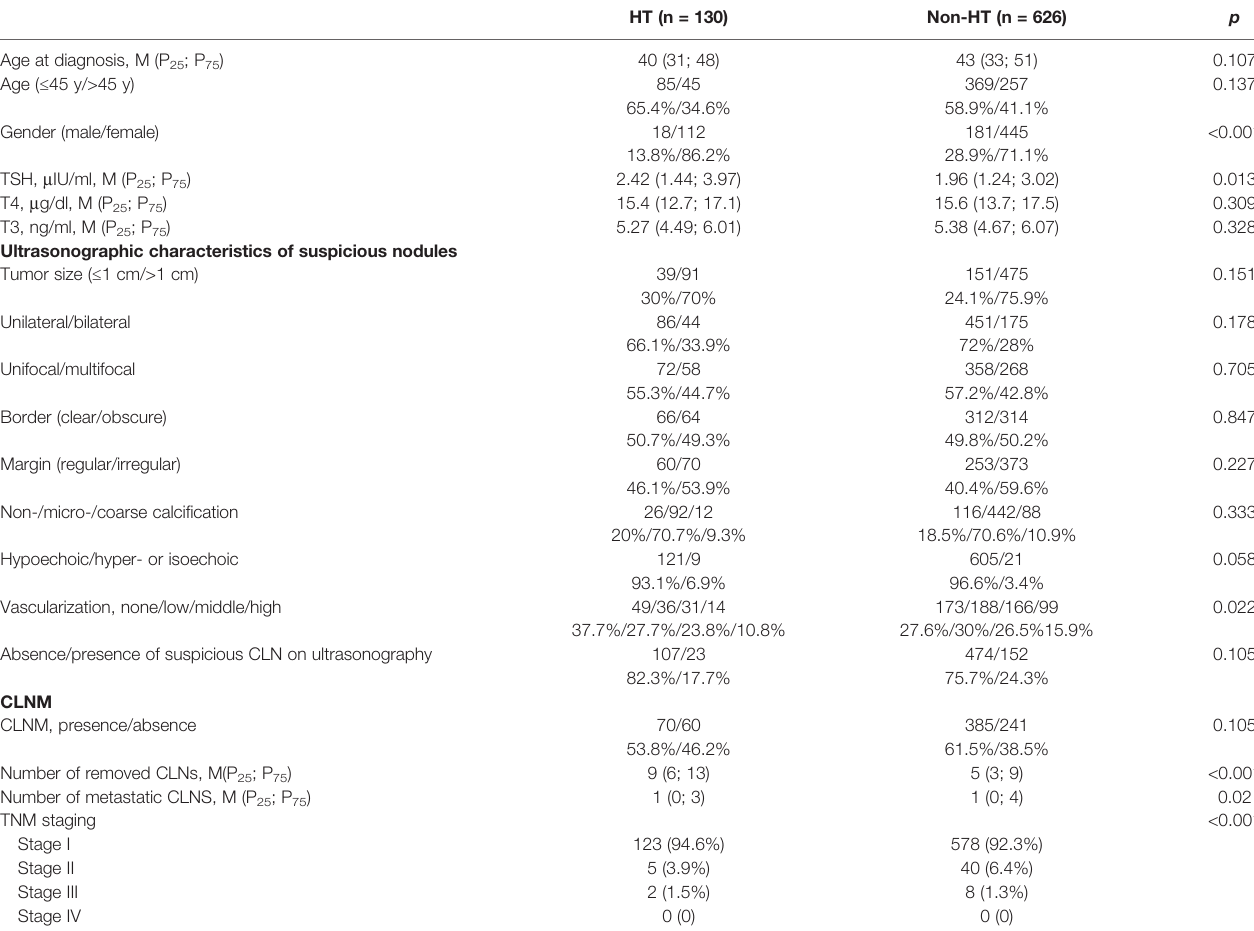
TABLE 1 | Clinicopathological characteristic of HT and non-HT PTC